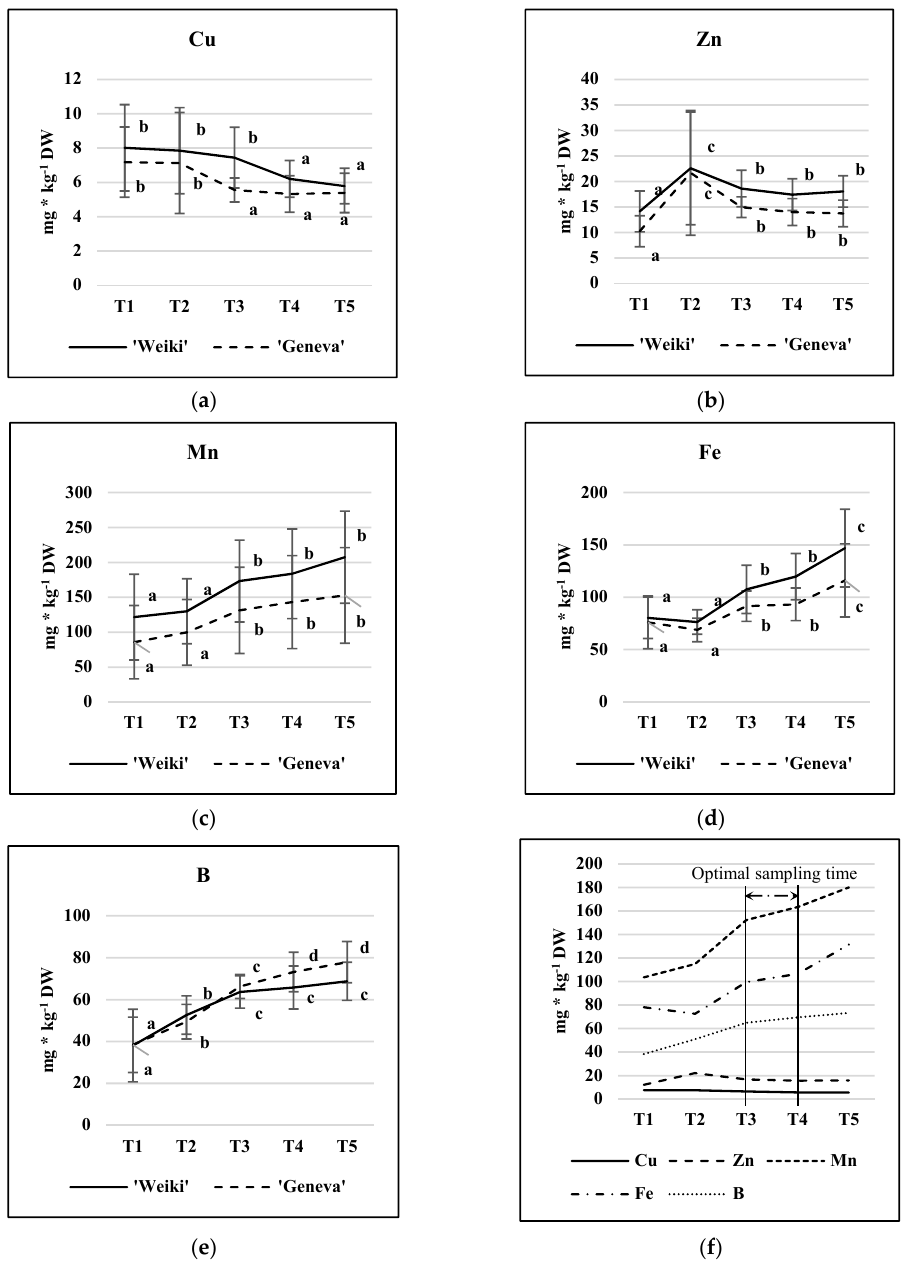
Figure 1. Leaf micronutrient concentration (mg kg − 1 DW): cultivar and time of sampling effects. ( a ) Cu; ( b ) Zn; ( c ) Mn; ( d ) Fe; ( e ) B; proposed range of sampling time for diagnostic purpose ( f ). Results are averaged over N level treatments and 2015–2016 growing seasons (avg ± SD, n = 18). In each year, leaves were sampled five times (T1—fully developed leaf stage (28.05.15 and 2.06.16), T2—the beginning of intensified fruit growth (23.06 in both, 2015 and 2016); T3—the peak of intensified fruit growth (16.07.15 and 14.07.16); T4—the full development of fruit (06.08.15 and 04.08.16); and T5—the beginning of fruit physiological maturity (27.08.15 and 25.08.16). Values for each cultivar marked with a different letter differ significantly at p ≤ 0.05 (Tukey HSD test). Cultivars were processed separately.